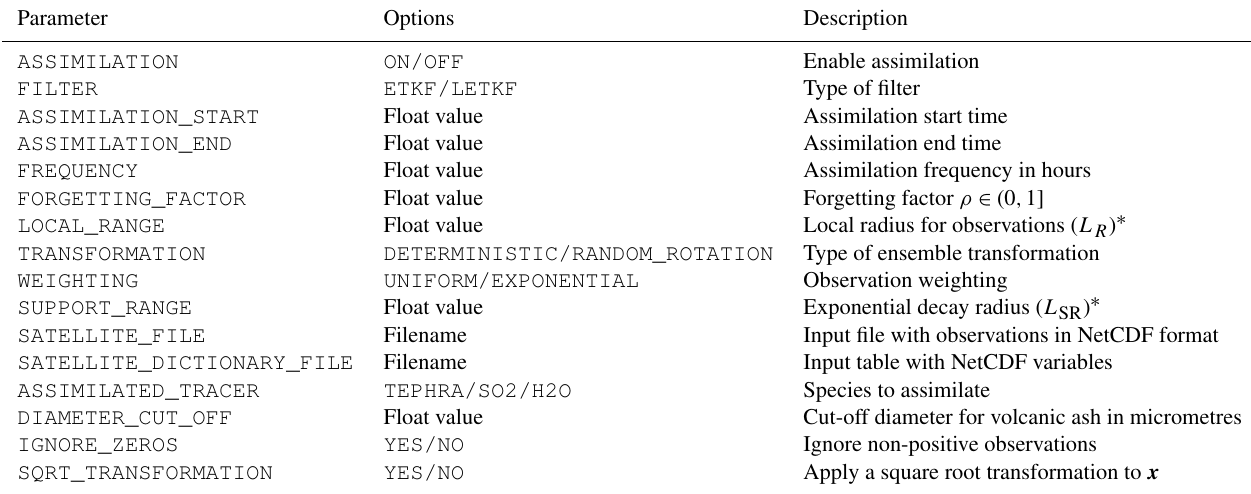
Table 1. List of input parameters required by the data assimilation block in the FALL3D input configuration